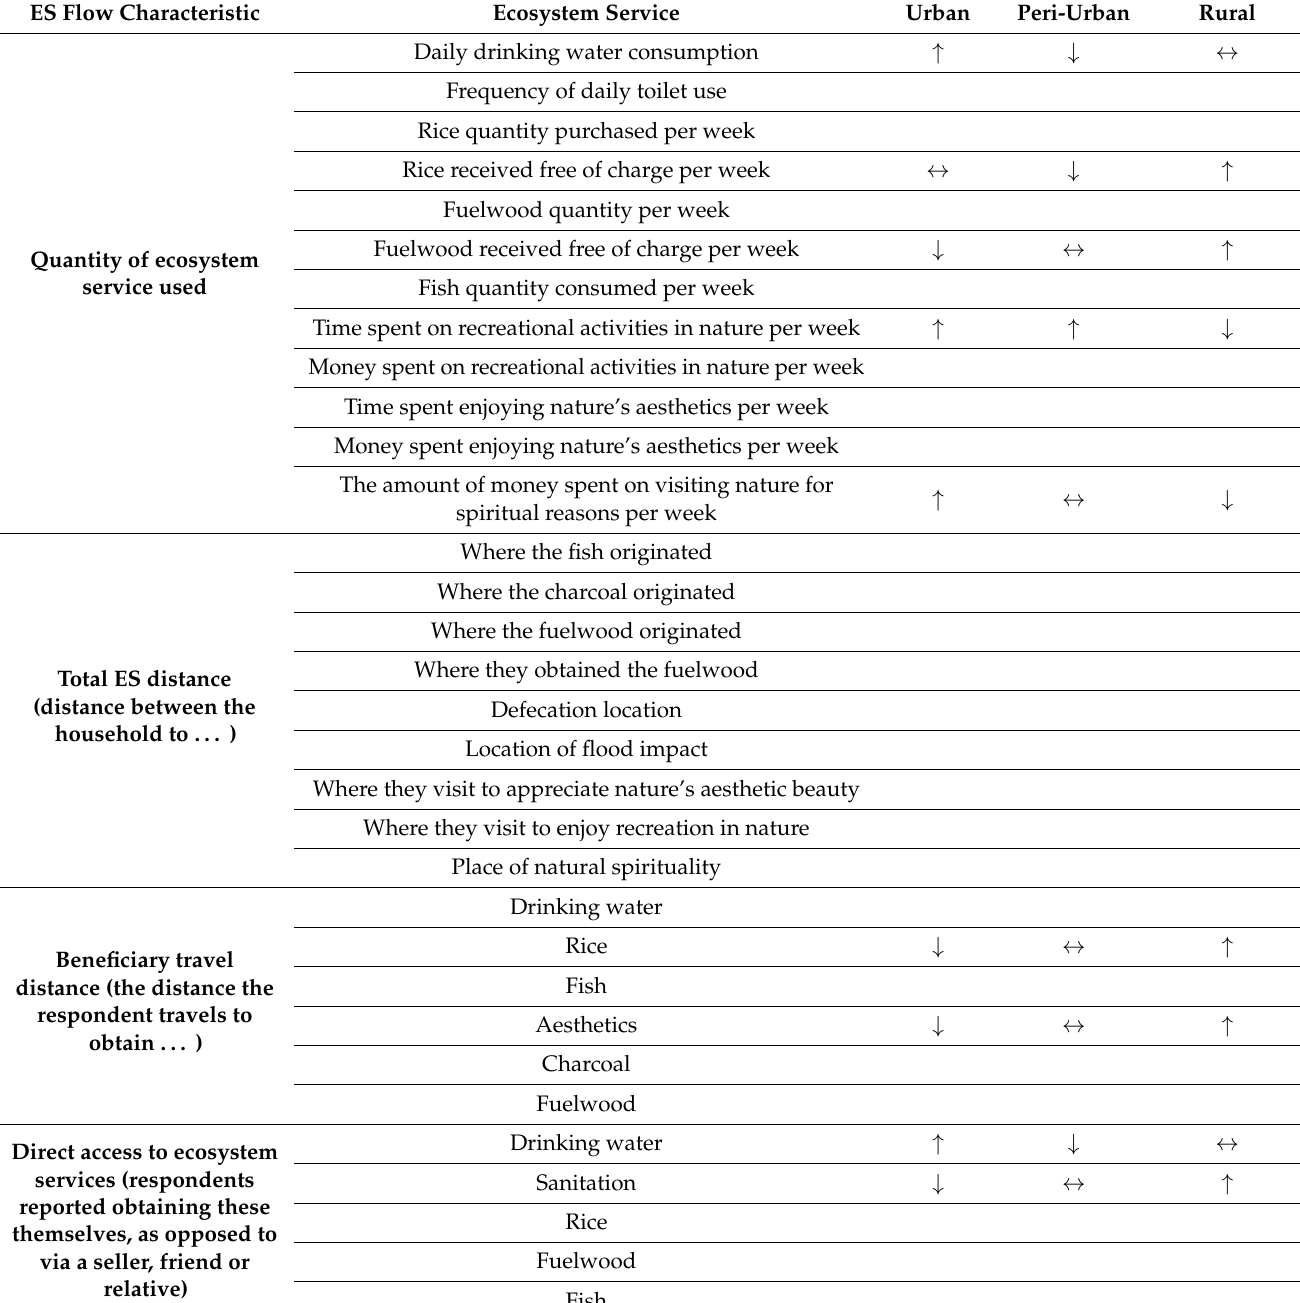
Table 3. Summary of differences in ecosystem services (ES) flows across the rural-urban spectrum around Hyderabad. Localities where respondents reported the highest ( ↑ ), in between ( ↔ ), and lowest ( ↓ ) values are shown. Blank cells indicate no significant difference across rural, peri-urban and urban areas. ES models that could not be run (e.g., due to low sample size) are not